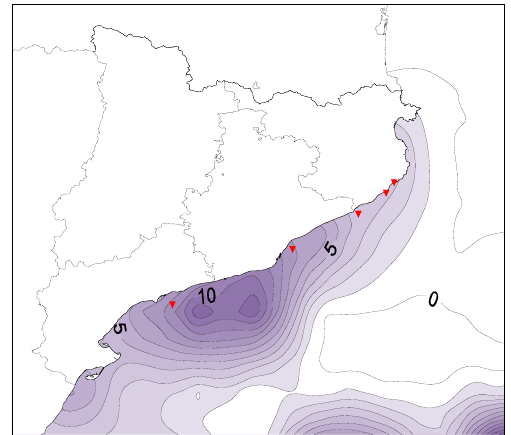
Figure 10. Density contours of vortex events (tornadoes and waterspouts) for the period 1980- 2009. The interval contours are 1 case/0.5ºx0.5º latitude longitude. Fig. 10. Density contours of vortex events (tornadoes and wa- terspouts) for the period 1980–2009. The interval contours are 1 case/0.5 ◦ × 0.5 ◦ latitude